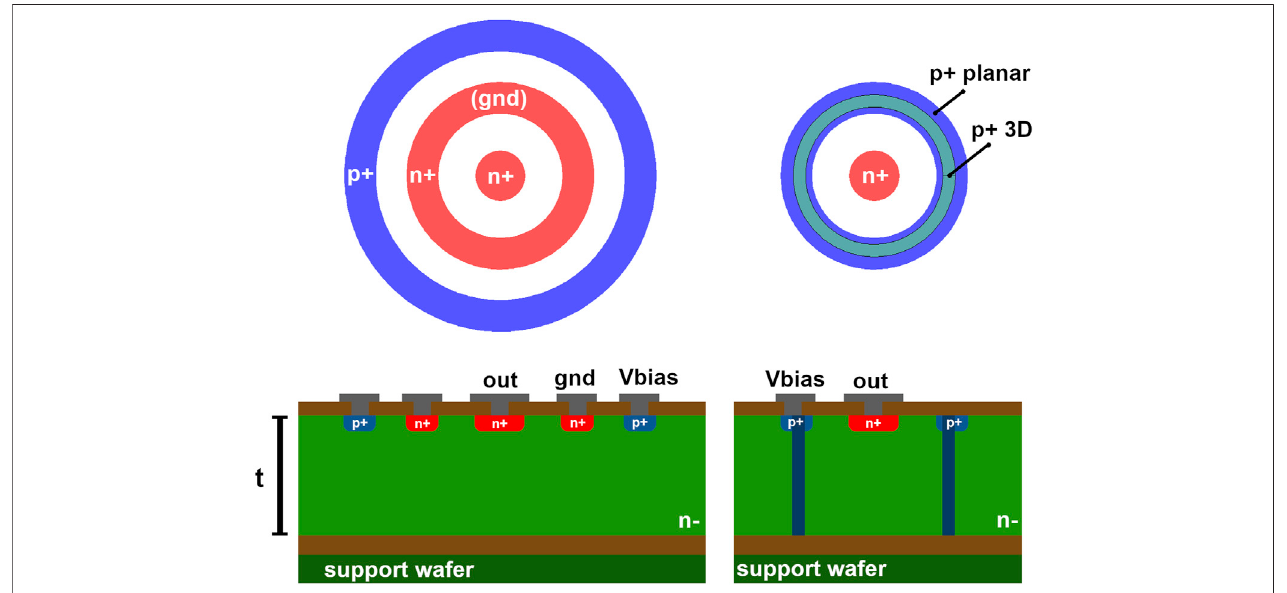
FIGURE 5 | Comparison between the layouts and cross section of the basic cell of a planar (left) and 3D (right) microdosimeter.